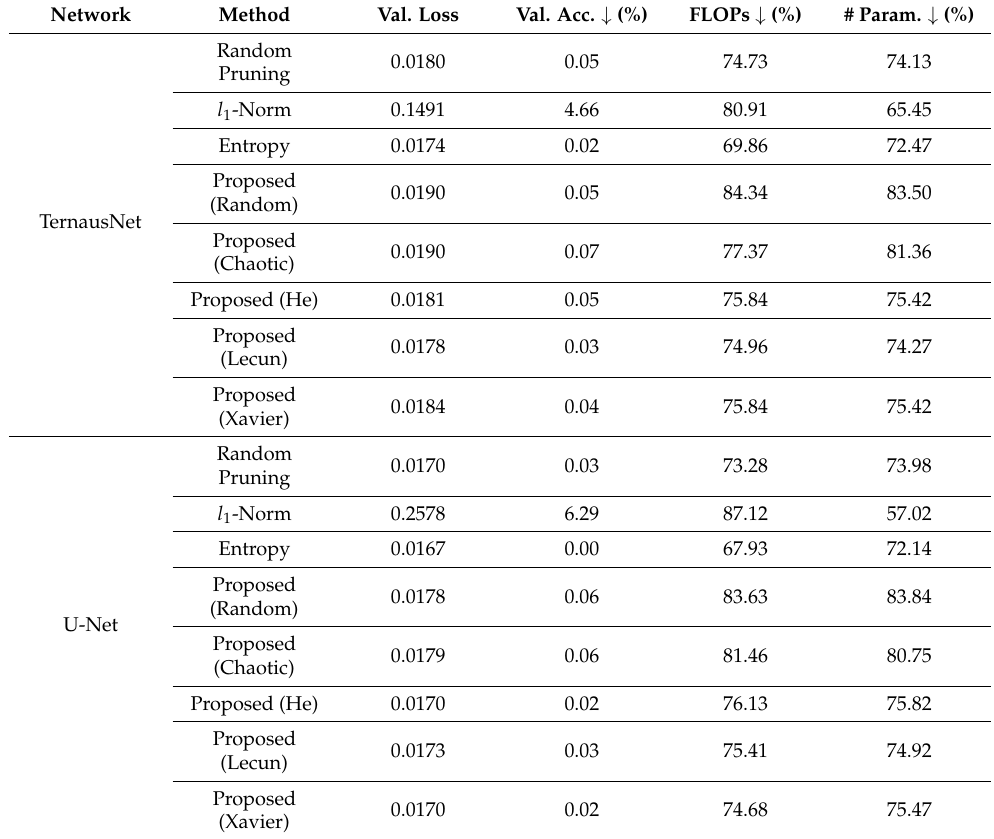
Table 4. Comparison with the state-of-the-art methods for pruning TernausNet and U-Net on AIRS dataset. “ ↓ ” represents the reduction